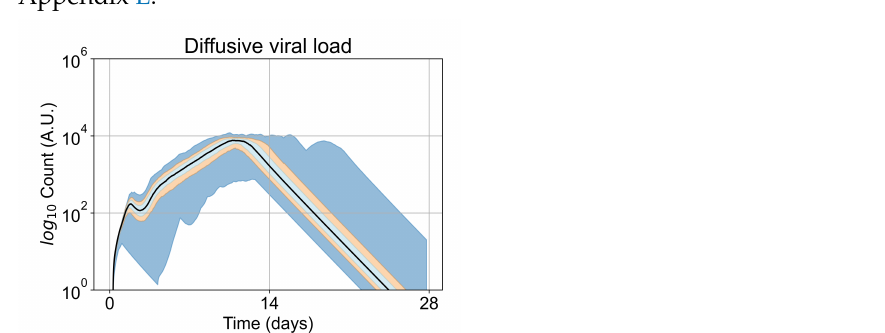
Figure 5. Extracellular viral load curve for untreated simulations with five initially infected cells in the tissue